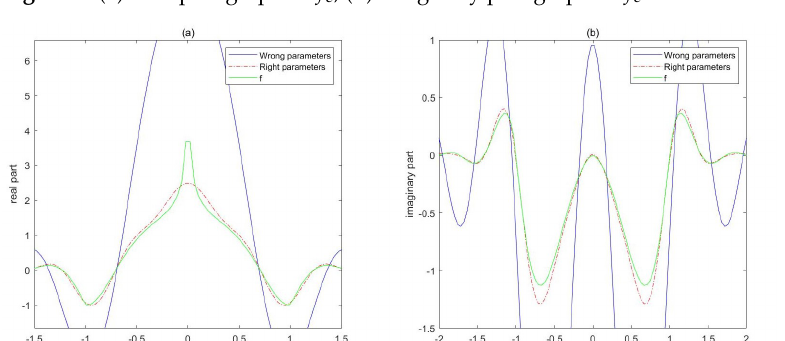
Figure 6. ( a ) Real part graph for comparison; ( b ) imaginary part graph for